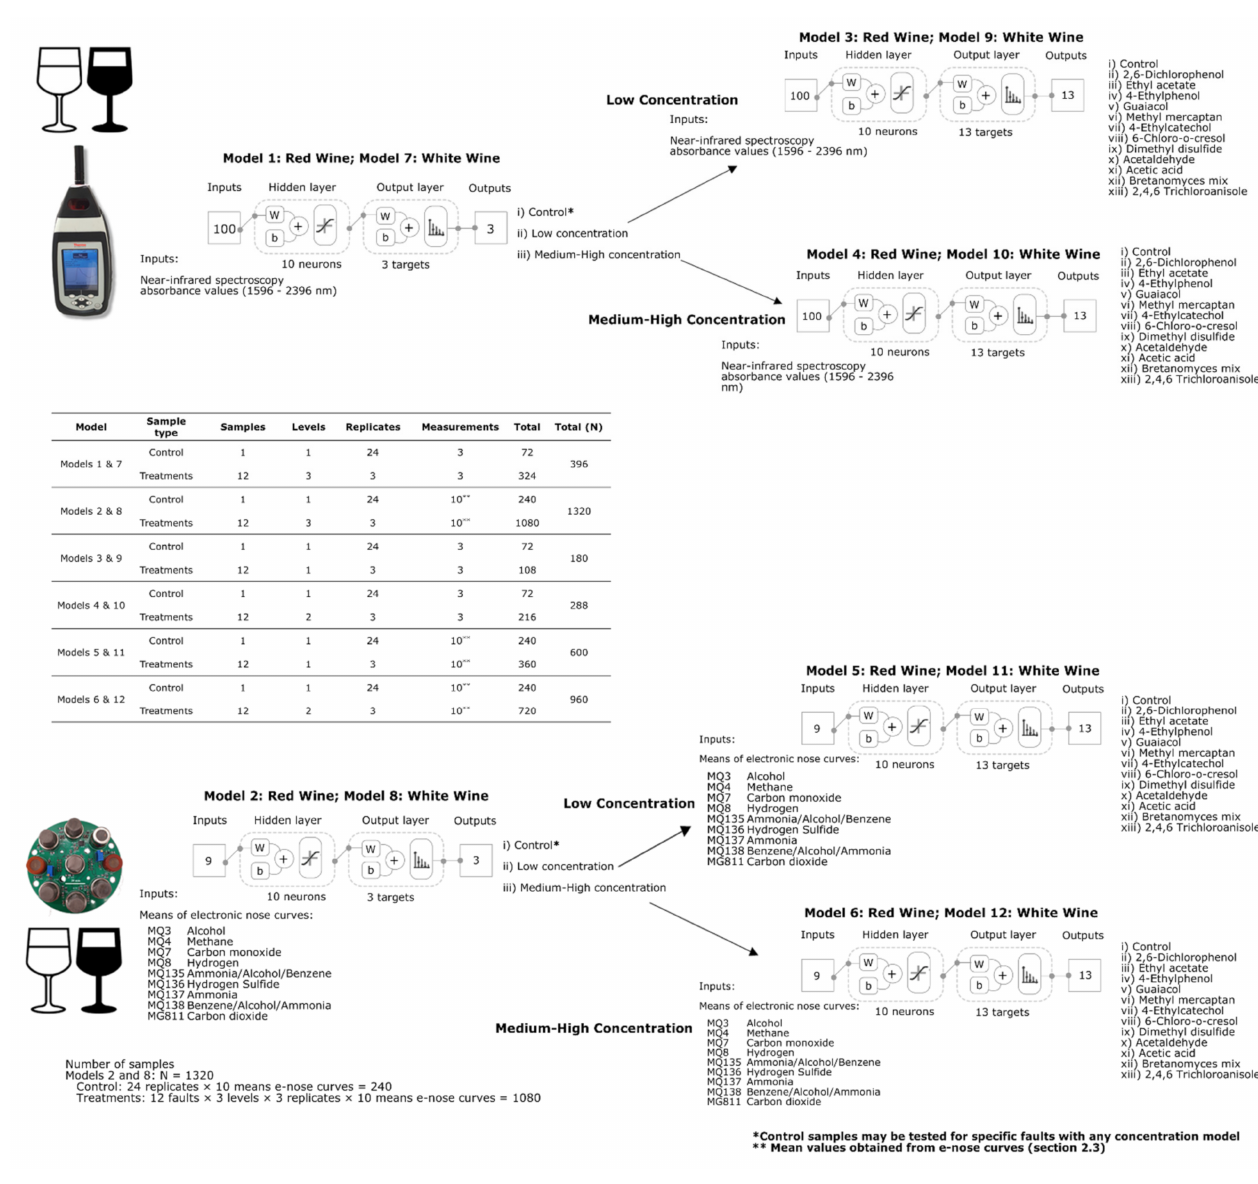
Figure 2. Diagrams of the digital instrumentation measurements and two-layer feedforward models with a tan–sigmoid function in the hidden layer and a Softmax function in the output layer for Models 1 (low concentration) and 2 (high concentration), and Models 3 (low concentration) and 4 (high concentration). Abbreviations: W: weights; b: